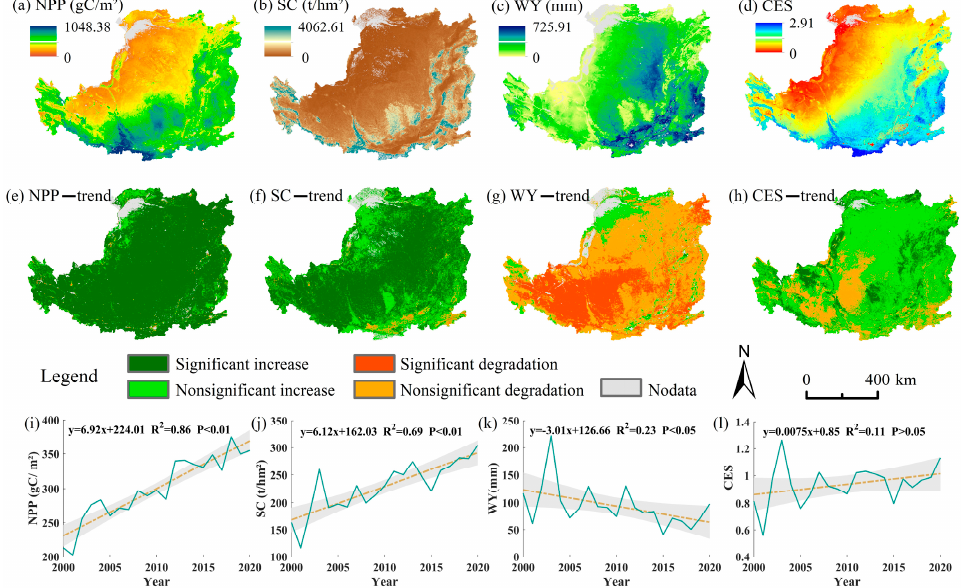
Figure 3. Spatial distribution and temporal variation of ESs (Note: ( a – d ) are the multi-year average spatial distribution of ESs; ( e – h ) are the spatial trend of ESs; ( i – l ) are the average annual trend of ESs). The relationships between ESs at pixles are shown in Figure 4. In terms of spatial distribution, NPP was synergistic with SC in 91.29% of the LP with 74.94% being signifi- cantly synergistic, while NPP was in a trade-off with WY in 72.93% of the area with a more